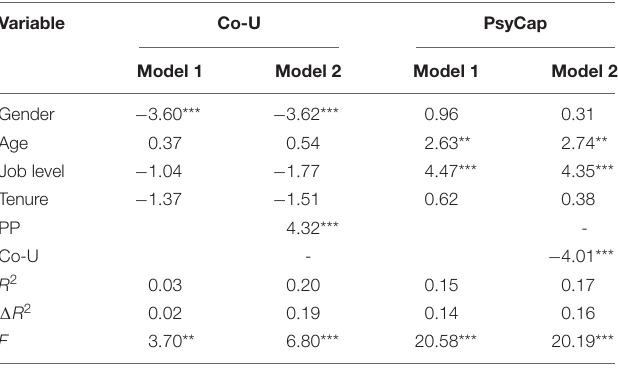
TABLE 4 | Results of regressions testing Hypothesis 1 and Hypothesis